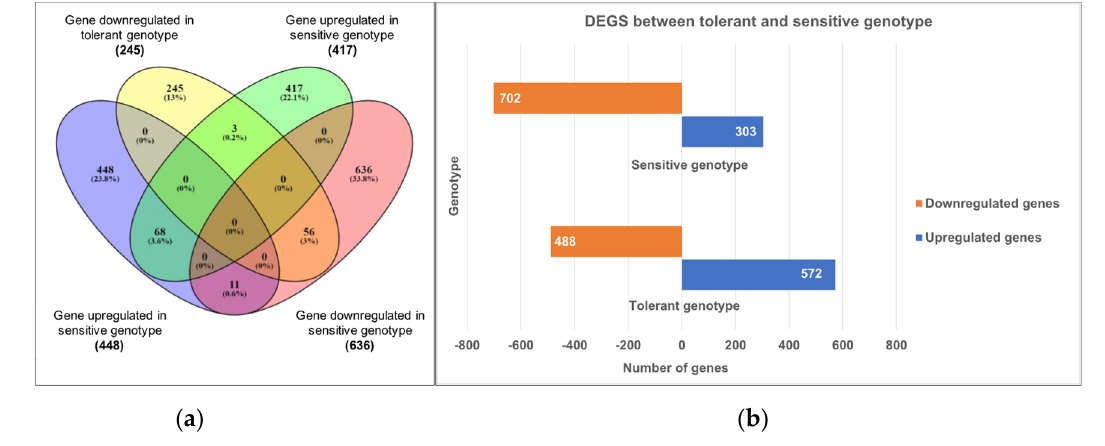
Figure 2. ( a ) Common and exclusive DEGs between the tolerant and sensitive genotypes. ( b ) The number of DEGs is significantly up- and down-regulated between the two genotypes.